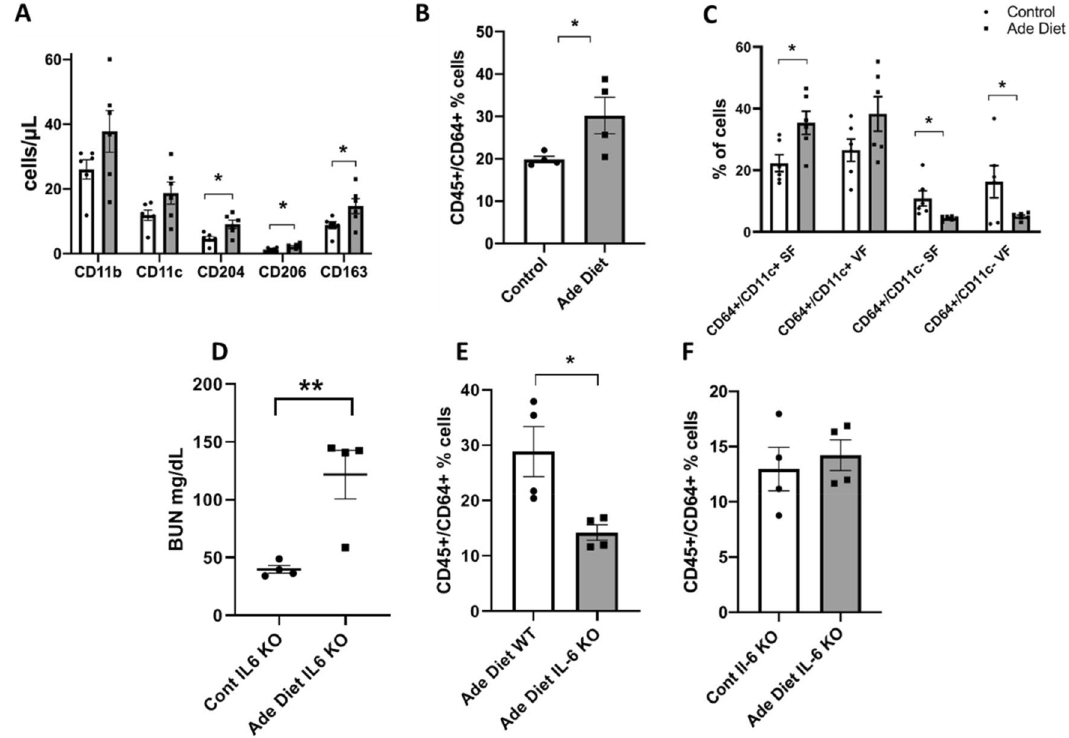
Figure 6. Peripheral and adipose tissue macrophage characteristics in uremia. ( A ) Peripheral blood flow cytometry showing the expression of different macrophage markers in adenine diet-induced mice versus control. ( B ) Adipose tissue flow cytometry showing the % of CD45+/CD64+ cells (macrophages) in adenine diet mice versus control mice. ( C ) Difference in % of expression of CD64+/CD11c+ and CD64+/CD11c- macrophage phenotypes in subcutaneous and visceral fat. ( D ) BUN level (mg/dL) in IL6 KO mice after adenine diet versus IL6 KO control mice. ( E ) Percentage of CD45+/CD64+ cells in adenine diet treated wild type and IL-6 KO mice; ( F ) Percentage of CD45+/CD64+ cells in IL-6 KO mice treated with adenine diet versus control. Unpaired t test, n = 4 for ( B ), ( D ), ( E ), n = 6 for ( A ), ( C ), error bars represent SEM *p ≤ 0.05. SF, subcutaneous fat. VF, visceral fat. Ade, adenine diet. Cont, control. KO,